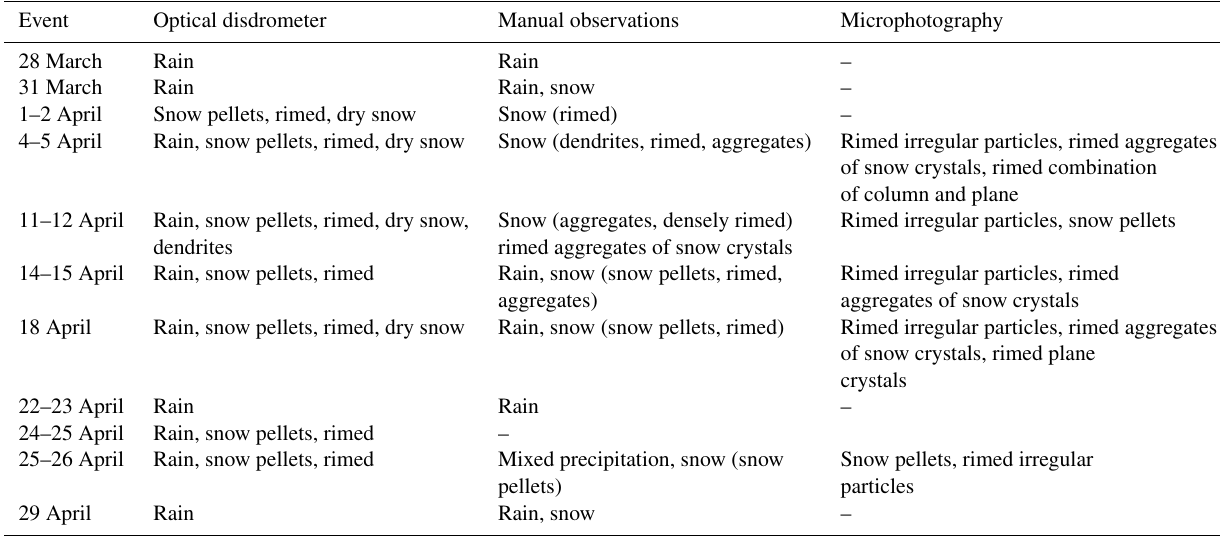
Table B1. A comparison of the optical disdrometer, manual and microphotography observations over the March–April 2015 period. Events between 15 and 23 March 2015 were omitted due to missing